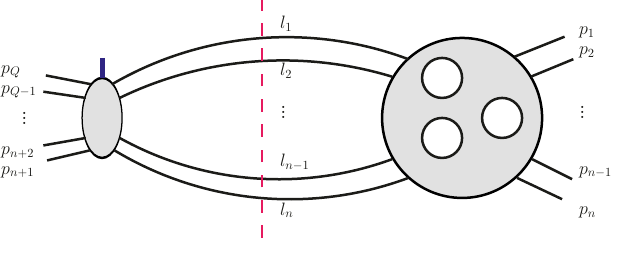
Figure 2 . An irreducible n -line cut of ϕ Q → Qϕ L -loop form factor. The l.h.s. of the cut is a ϕ Q → Qϕ tree form factor, the r.h.s. represents a ( L − n + 1) -loop 2 n -point scattering